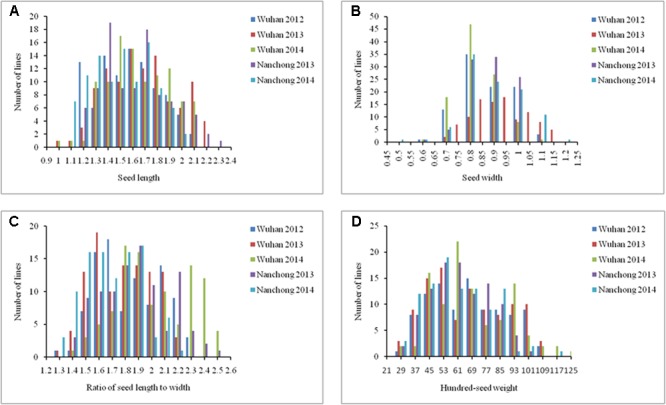
Phenotypic distribution of 4 seed-related traits in the peanut panel in the five different environments. (A) Seed length; (B) Seed width; (C) Ratio of seed length to width; (D) Hundred-seed weight.